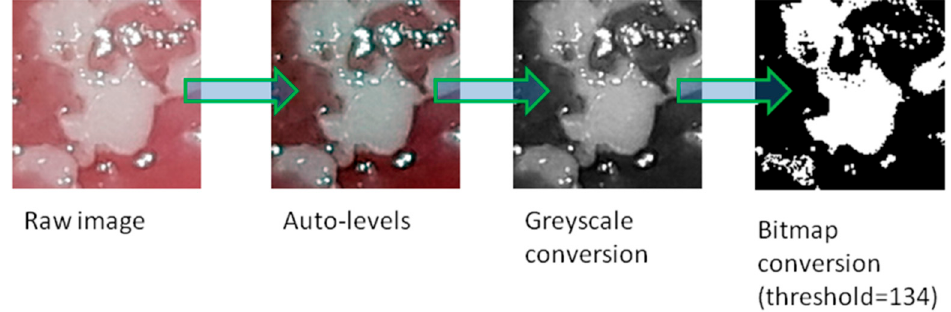
Figure 2. All graphical operations to prepare an image for texture and fractal dimension analysis.